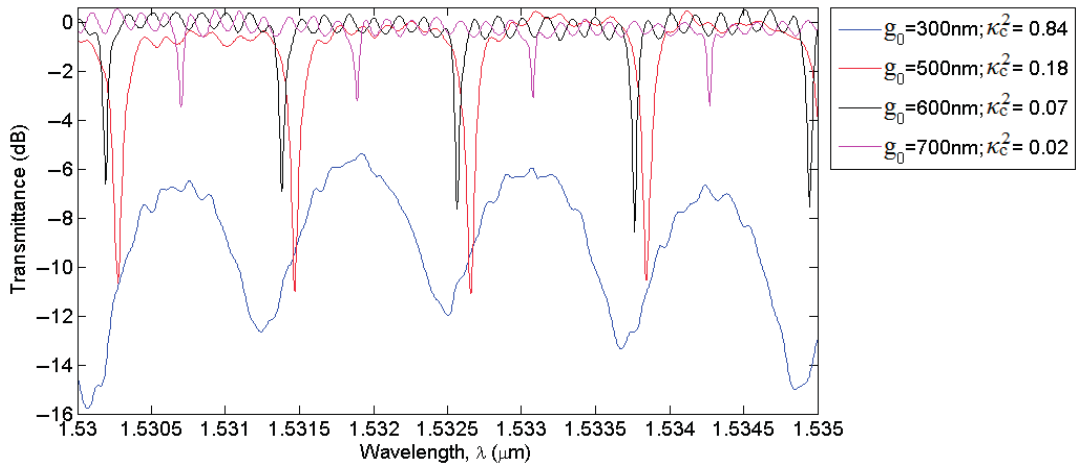
Figure 8. Influence of different values of arc-shaped DC gap, g 0 , on Vernier B Ring #1 transmittances.